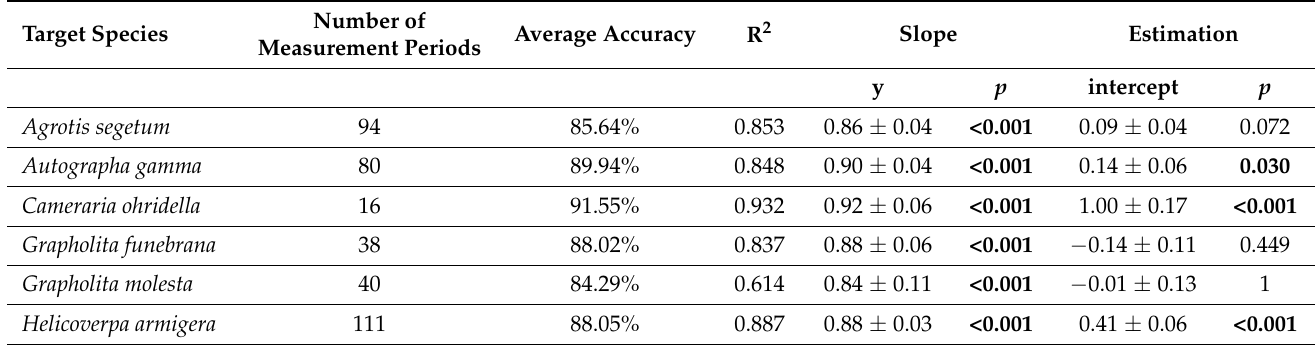
Table 3. The average detection accuracy and reliability (R 2 ) of ZooLog VARL probes for the six target species with the slopes and intercepts of linear models fitted to the manually and automatically counted data. Significant p values ( p < 0.05) are highlighted in